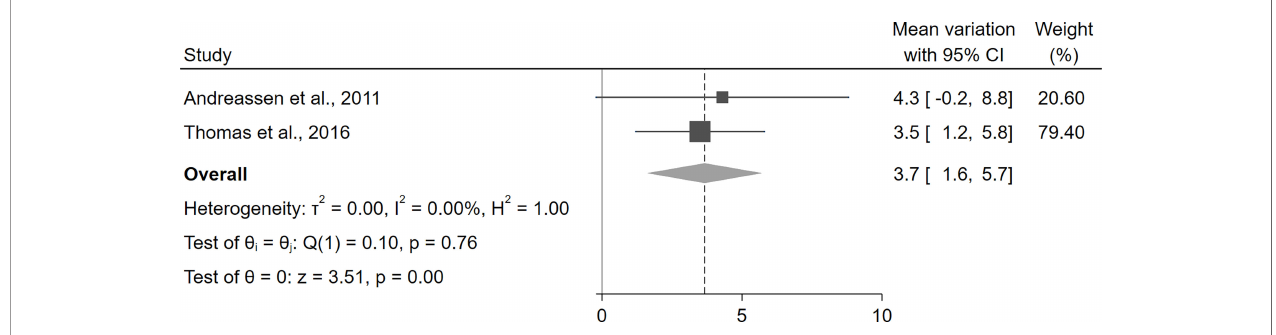
FIGURE 4 | Variation of LVMi before and after treatment with rhGH in patients with GHD. CI, con fi dence interval; GHD, growth hormone de fi ciency; LVMi, left ventricular mass index; rhGH, recombinant human